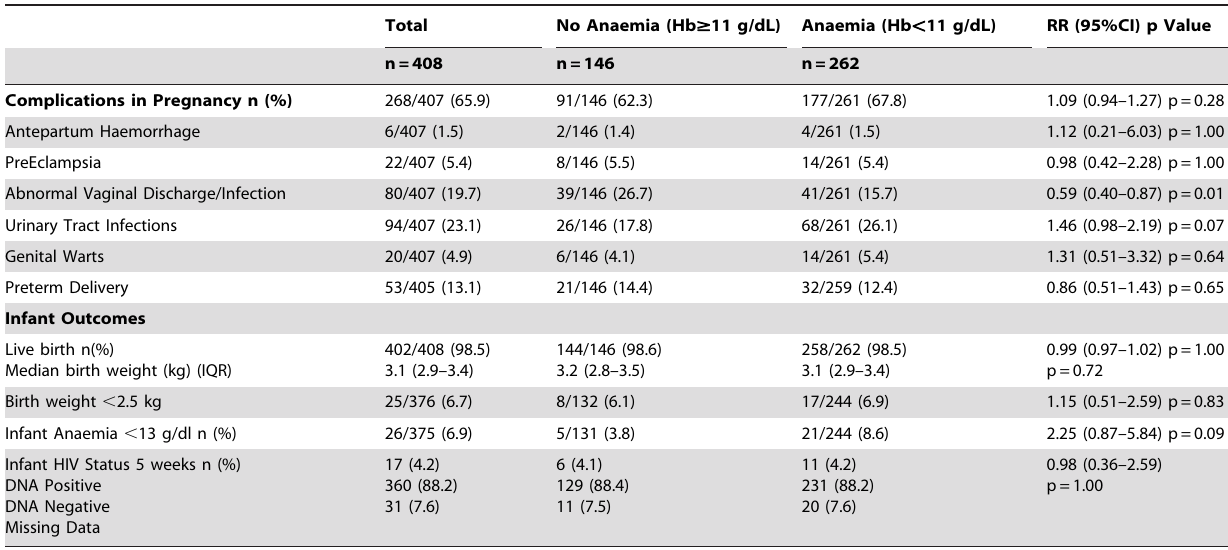
Table 2. Obstetric and Infant Outcomes in Association with Anaemia in